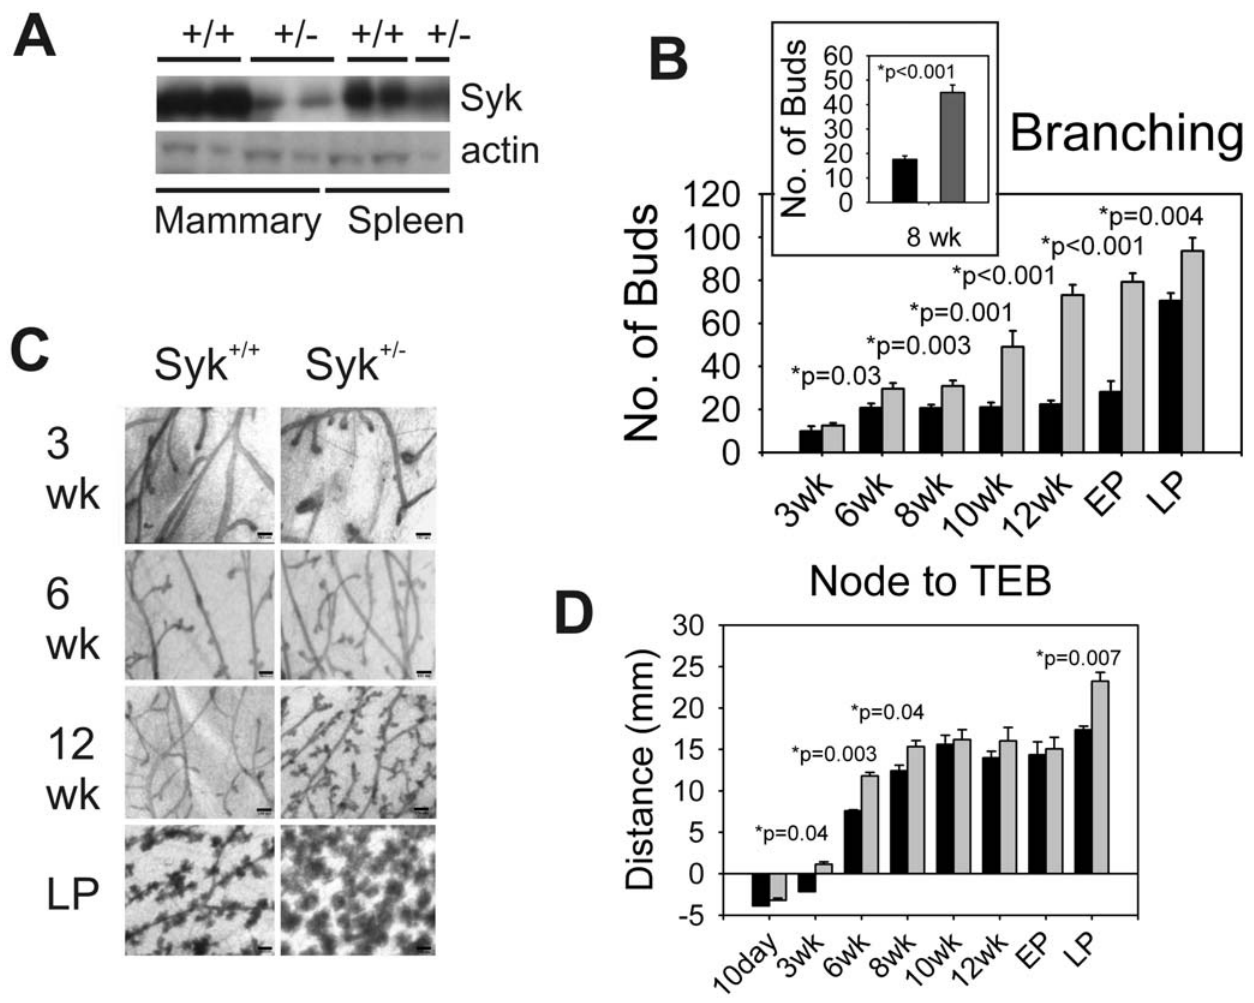
Figure 5. Enhanced branching morphogenesis in mammary glands of Syk + / 2 mice. (A) Syk protein is decreased in mammary gland extracts (minus the mammary gland lymph node) and spleen from 12-week virgin Syk + / 2 heterozygous compared with Syk + / + wild type females. Spleen extracts were used as positive control. (B) The average number of buds were counted in mammary glands from Syk + / + wild type (black bars) and Syk + / 2 heterozygous mice (gray bars) from 3-, 6-, 8-, 10-, 12-week virgin and early and late pregnancy females (EP and LP, respectively). P value was significant by the student’s t-test for 6-, 8-, 10-, 12-week virgin females and early- and late-pregnancy females (n=3 animals per time point). In a separate experiment, mammary glands from 10 additional wild type and 10 heterozygous knockout Syk mice were examined at 8 weeks confirming the increase in bud formation after partial Syk loss ( B, inset ). Data are represented as means from three mice + / 2 SEM except for B, inset , where n=10 mice. (C) Representative images of mammary glands from Syk + / + wild type and Syk + / 2 heterozygote knockout mice. Scale bars correspond to 150 m m in all panels. (D) The mean distance was determined from lymph node to the distal end of ducts in mammary glands from Syk + / + wild type (black bars) and Syk + / 2 heterozygous mice (gray bars) at 10-day and 3-,6-,8-,10, 12-week virgin and early and late pregnancy females (n=3 animals per time point). P value is significant by the student’s t-test for 3-, 6-, 8-week virgin females and late-pregnancy females. Data are represented as means + / 2 SEM for three glands